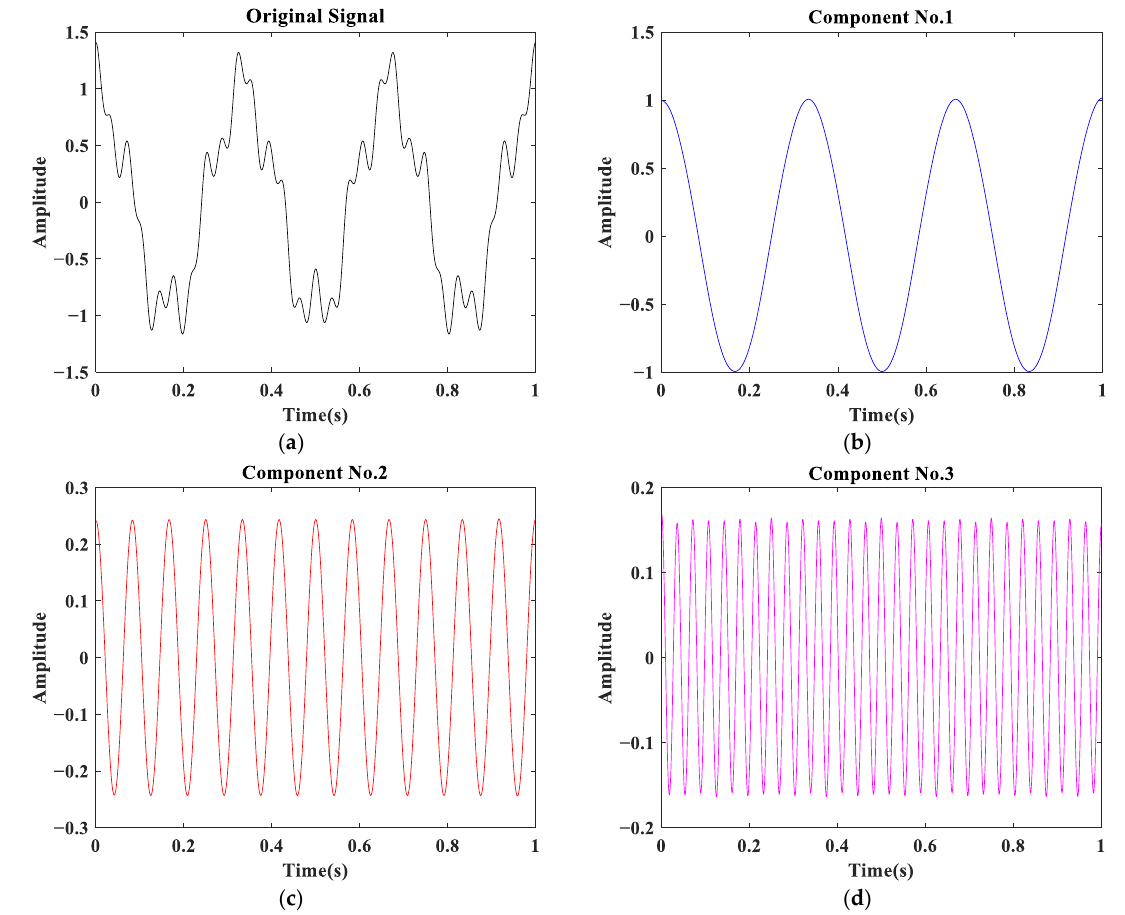
Figure A1. The decomposition result by VMD when K = 3 and α = 2500. ( a ) The original signal; ( b ) No.1 mode component; ( c ) No.2 mode component; ( d ) No.3 mode component.